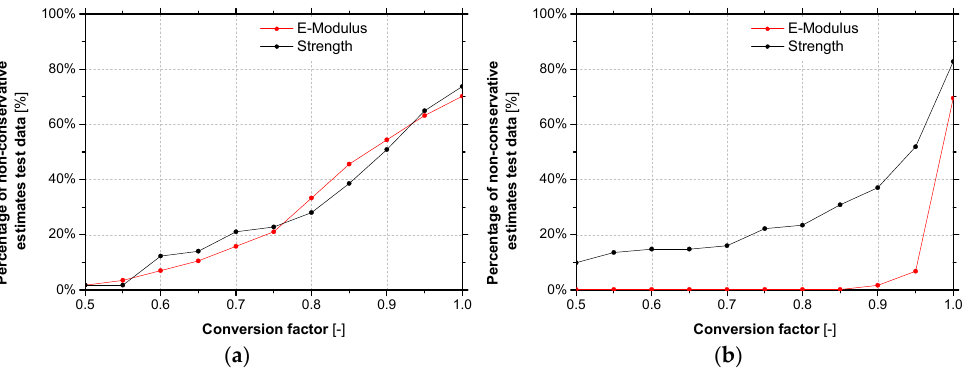
Figure 15. Percentage of non-conservatively estimated data points as function of the conversion factor for ( a ) epoxy adhesives and ( b ) CFRP laminates.